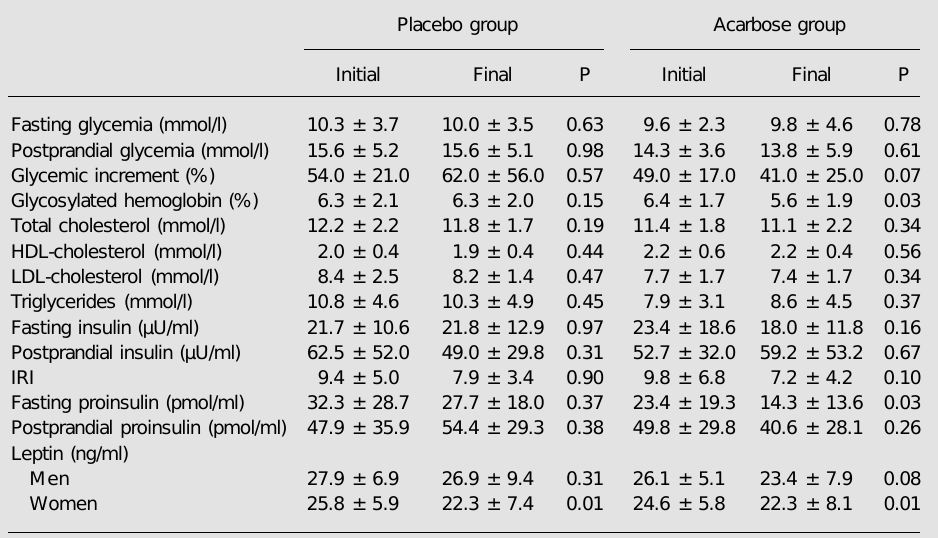
Table 2. Metabolic and hormonal data obtained before randomization and at the end of the treatment period. Placebo group Acarbose